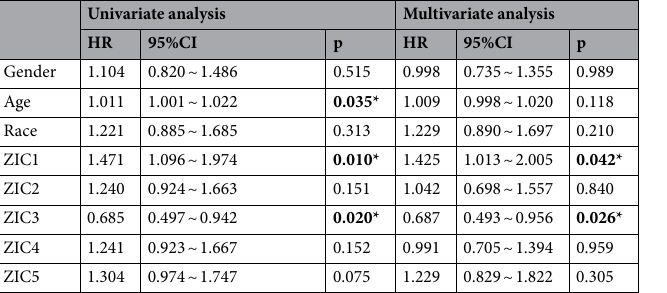
Table 2. Univariate and multivariate analysis analysis of overall survival in GBM patients. (TCGA database). HR hazard ration, 95% CI 95% confidential interval. * p < 0.05, ** p < 0.01, *** p < 0.001. Bold values indicate clinical